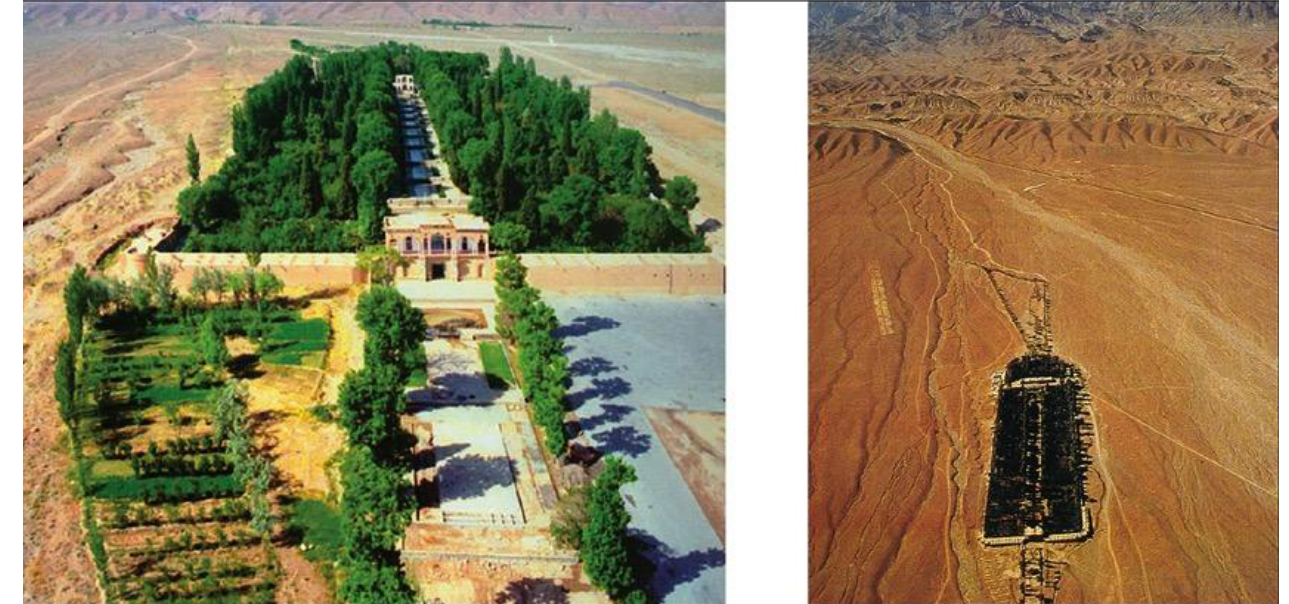
Figure 15. Water as the main element in Persian garden, Bagh-e-Shazdeh pools and water channels (Khansari et al.